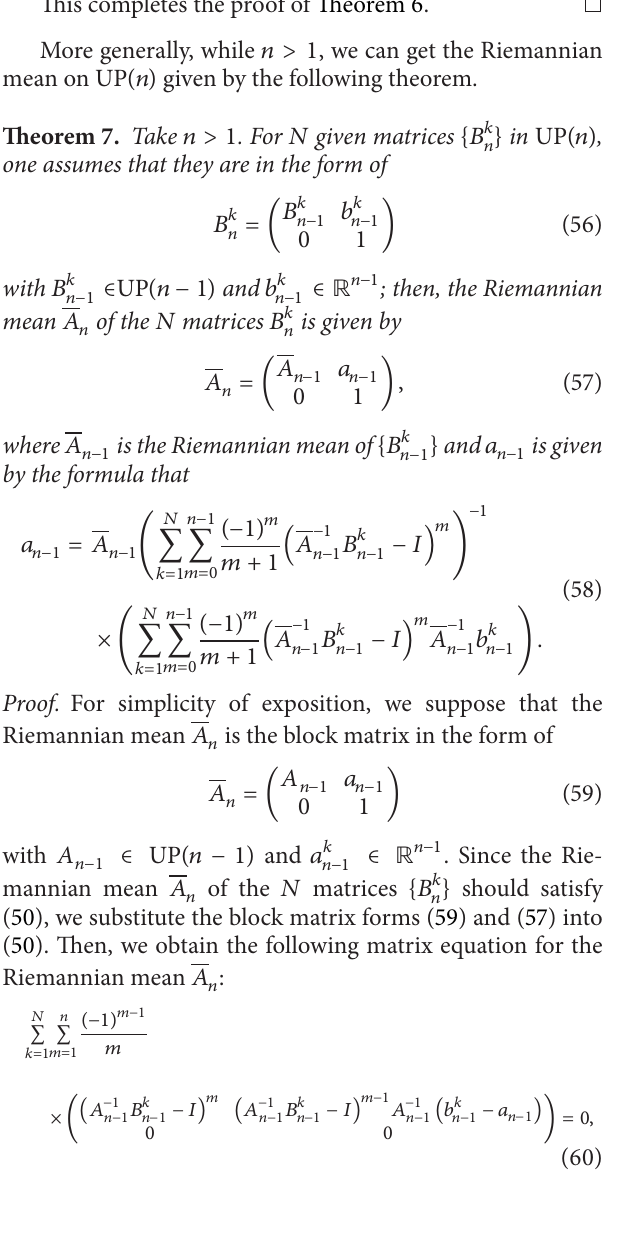
Figure 3: The geodesic triangle on 𝐻(3)